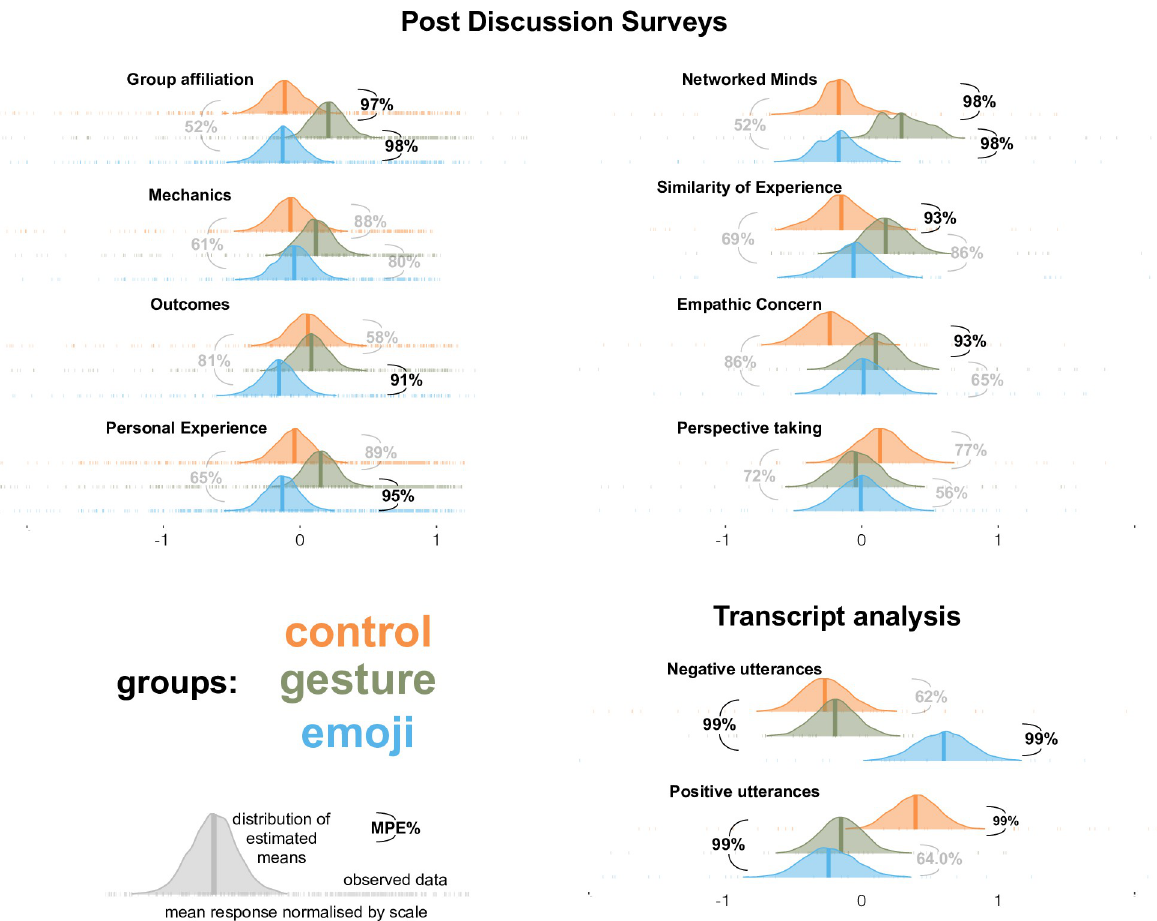
Fig 4. Results of Experiment 2 post discussion surveys and transcript analysis. Observed data are given in check marks, average values for each measure are shown by vertical lines, and the probability distribution of those averages as estimated by the models are given by shaded areas. The probability that there was a different any two conditions (MPE) is given in brackets, with those showing strong evidence in bold.